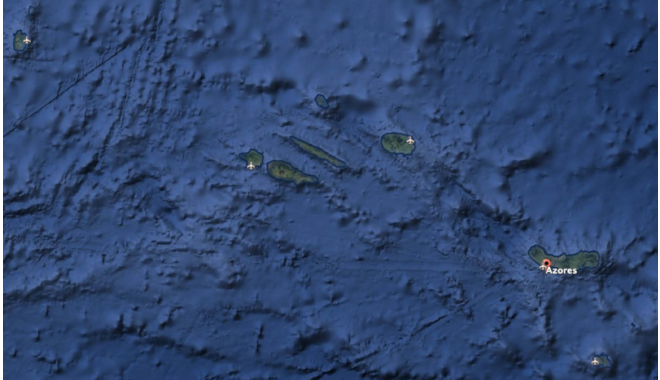
Figure 1. Macaronesia Region: The Canarias.